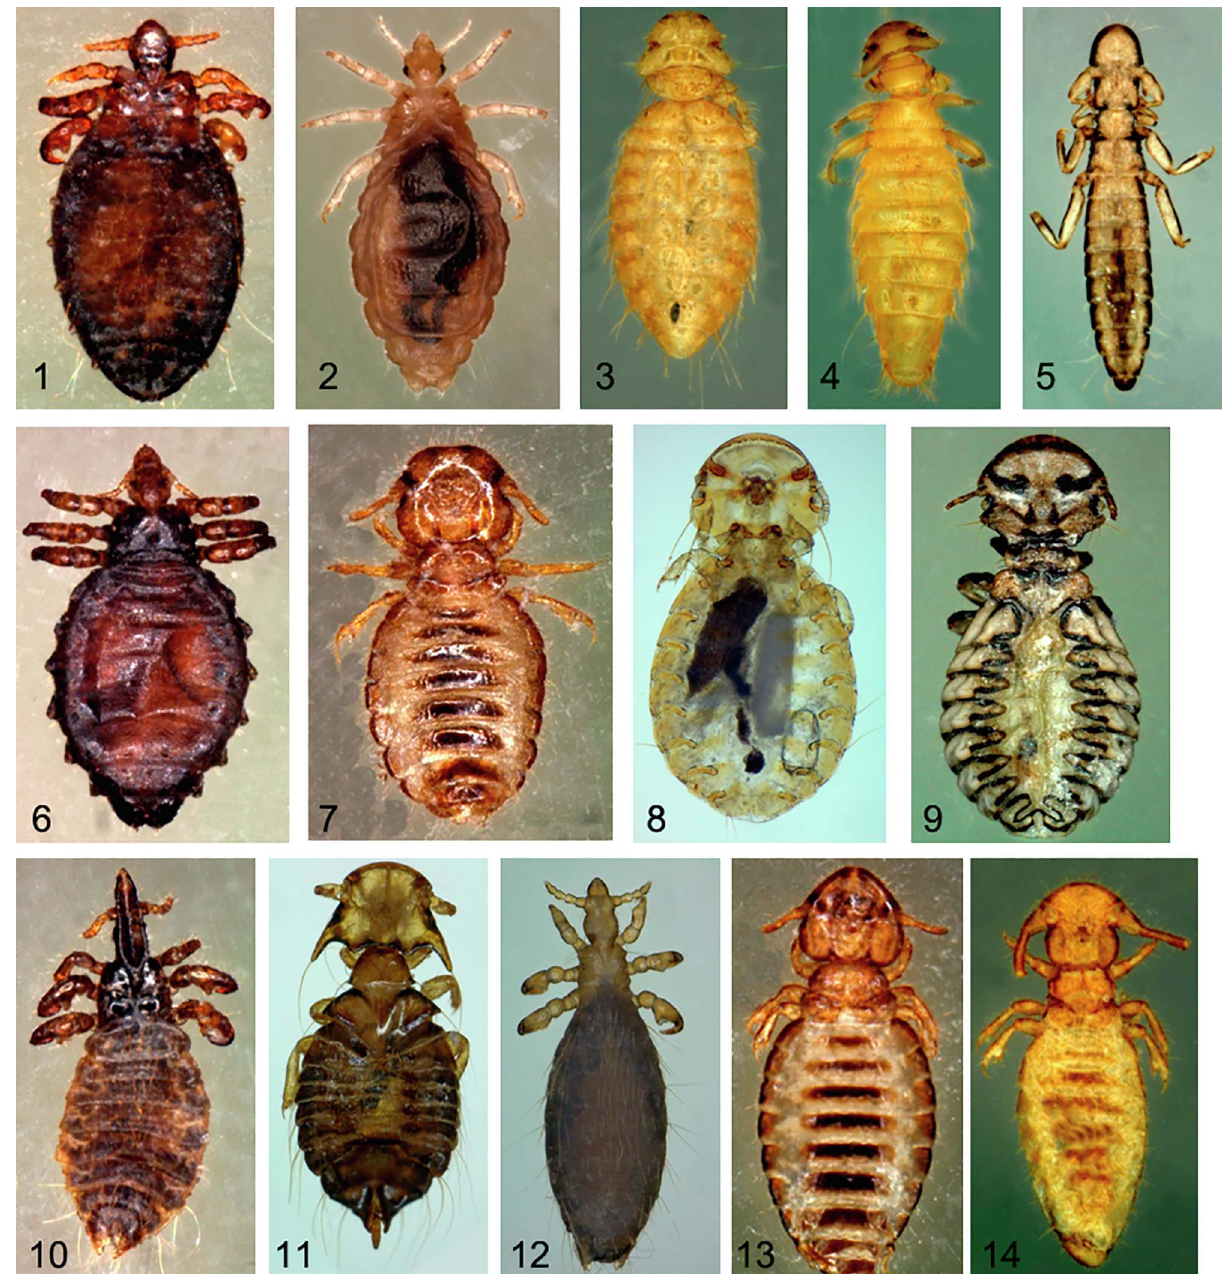
Figure 1. Photographs of habitus of 13 species of lice collected from three regions of northeastern Algeria: Solenopotes capillatus (1); Menopon gallinae (3); Menacanthus stramineus (4); Lipeurus caponis (5); Haematopinus eurysternus (6); Bovicola caprae (7); Goniocotes gallinae (8); Goniodes gigas (9); Linognathus vituli (10); Chelopistes meleagridis (11); Linognathus africanus (12); Bovicola bovis (13); Bovicola ovis (14). Laboratory specimens of Pediculus humanus corporis (2) were also used in this